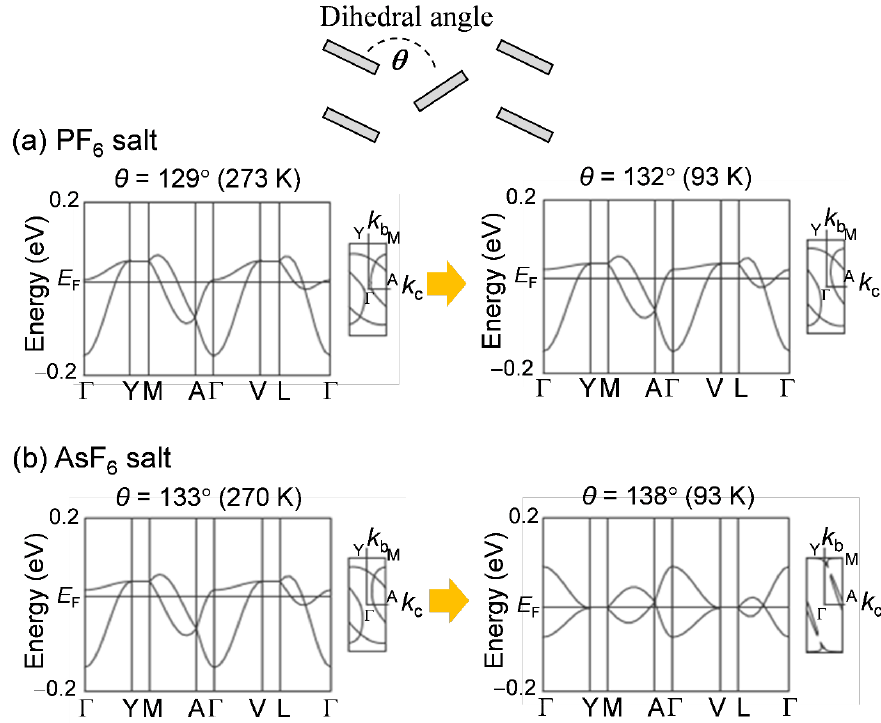
Figure 4. Temperature dependence of the band dispersions and Fermi surfaces of the ( a ) PF 6 and ( b ) AsF 6 salts.